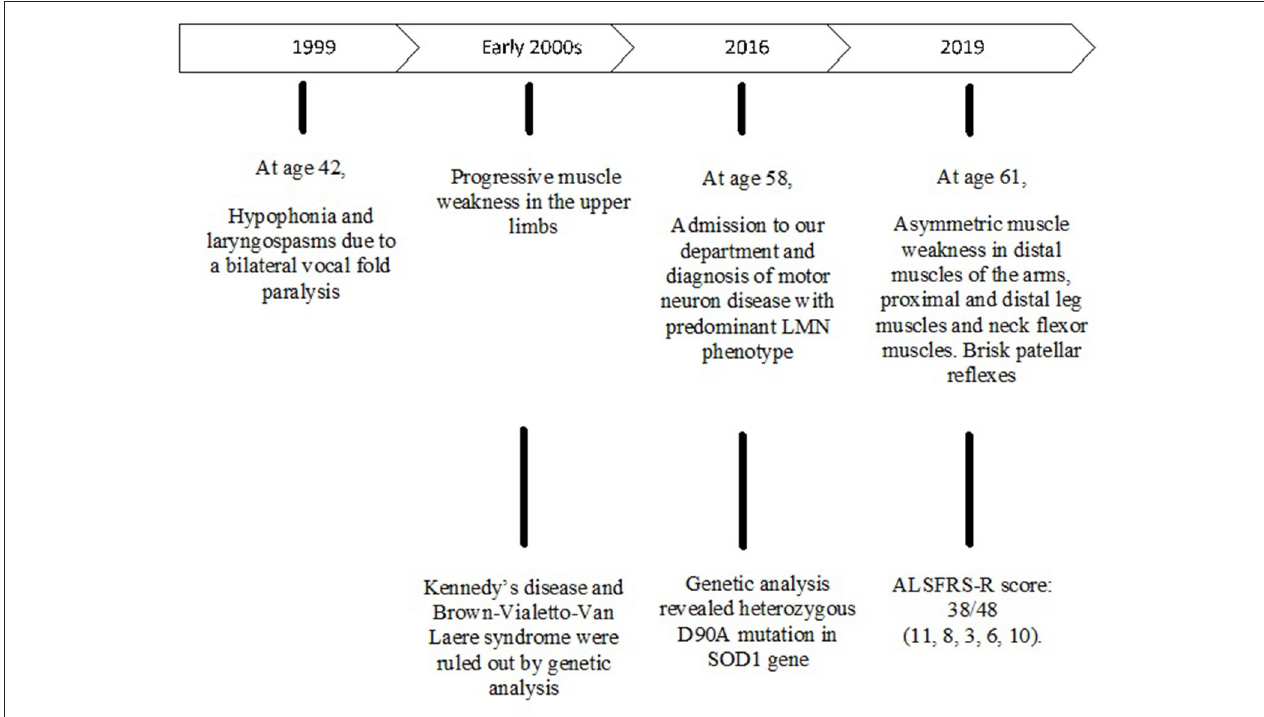
FIGURE 1 | Sanger sequencing electropherogram; “*” shows the variant c.272A > C in the exon 4 of SOD1 in the